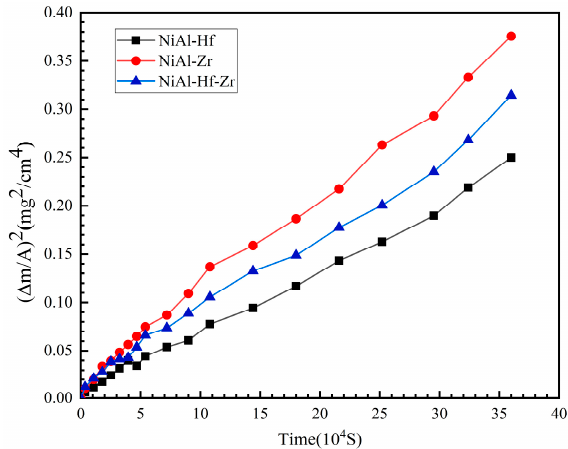
Figure 5. Square of the mass gain of the NiAl–Hf, NiAl–Zr and NiAl–Hf–Zr coatings during 100 h cyclic oxidation at 1150 °C.